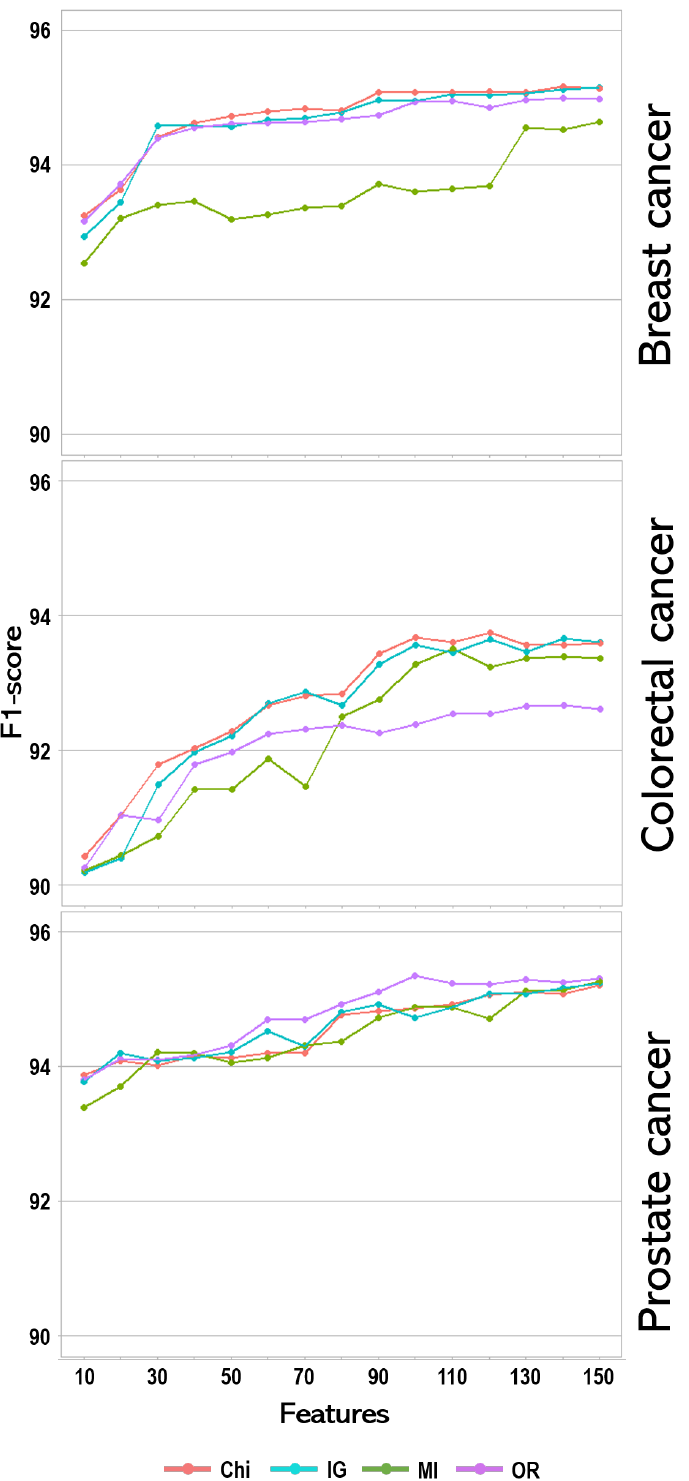
Figure 9. F1-score of RF for the three cancer type, showing patterns in performance with each feature selection method and over feature